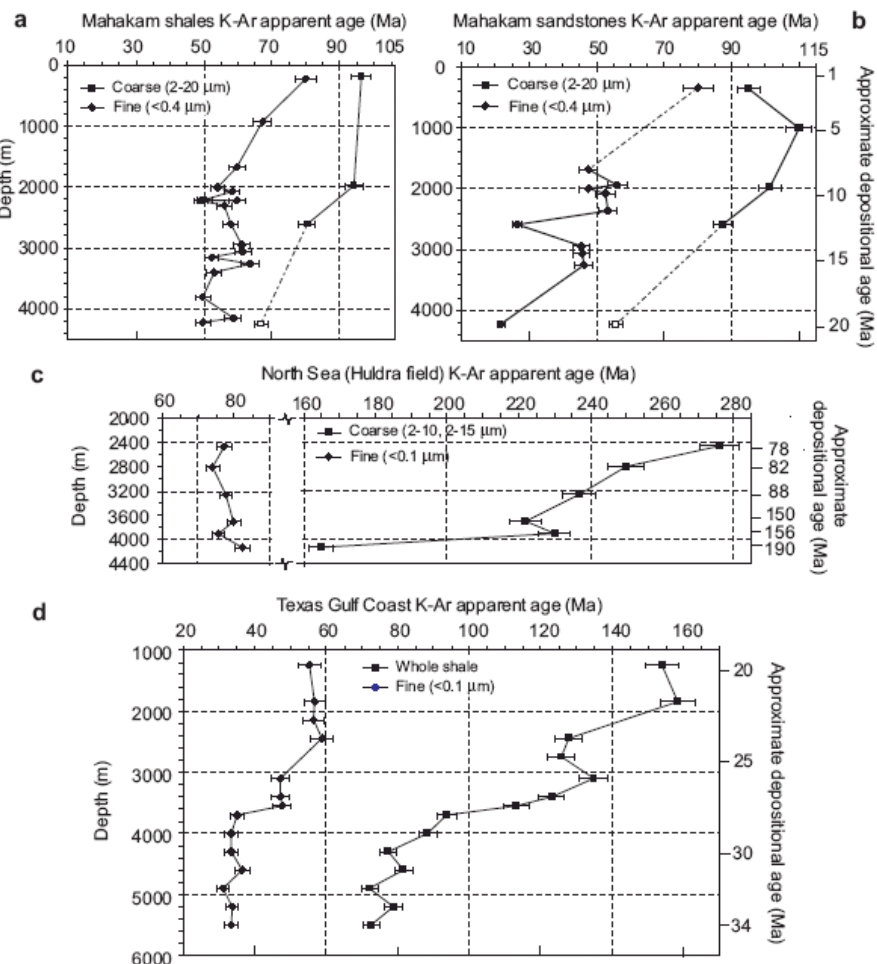
Figure 2. K-Ar apparent ages of the coarse- and fine-grained size fractions from: ( a ) the shales of the Mahakam Basin; ( b ) the sandstones of the Mahakam Basin [24,36]; ( c ) the sequence of the Huldra field in the North Sea [22]; ( d ) the sequence of the Gulf Coast [37]. The K-Ar ages in the latter were recalculated using the atomic ratio 40 K/K = 1.167 × 10 − 4 , λ = 5.543 × 10 − 10 yr − 1 , and λ a = 5.810 × 10 − 11 yr − 1 [41]. Two of the lines are partly dotted when the two successive samples are quite distant.